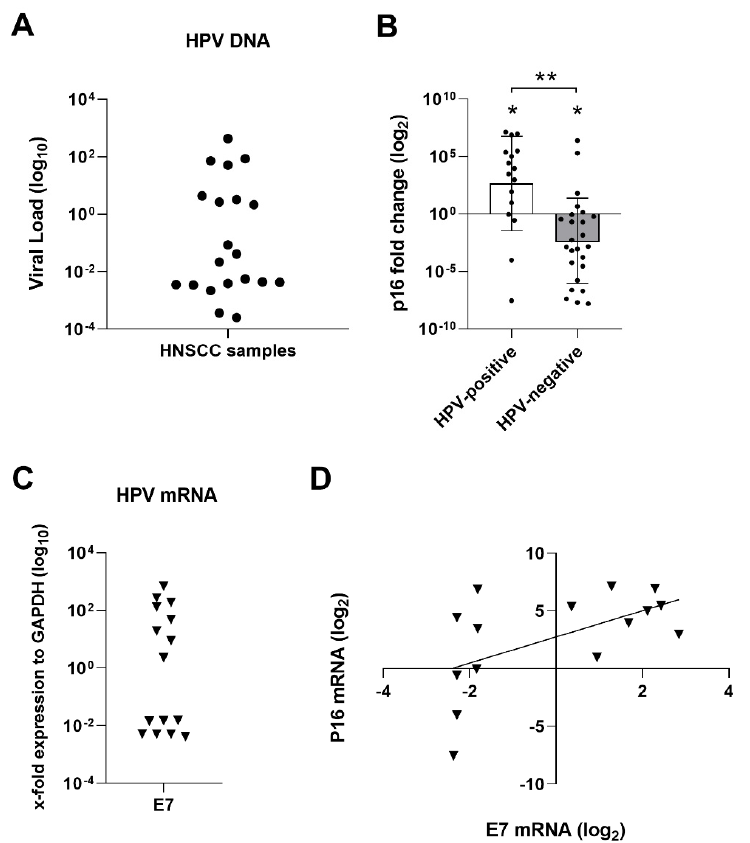
Figure 1. Analysis of classical markers for stratification of HNSCC samples. Statistical significance was indicated as * for p < 0.05 and ** for p < 0.0001; ( A ) viral load quantification of HPV-positive HNSCC samples by qPCR; ( B ) differential p16 mRNA expression in HNSCC samples analyzed by qPCR; ( C ) Viral E7 mRNA expression in HPV-positive HNSCC samples; ( D ) Spearman correlation analyses between the expression of E7 (log 2 ) oncogene and p16 (log 2 ) showed correlation (r = 0.59; p < 0.05) in HPV-positive HNSCC tumor samples.